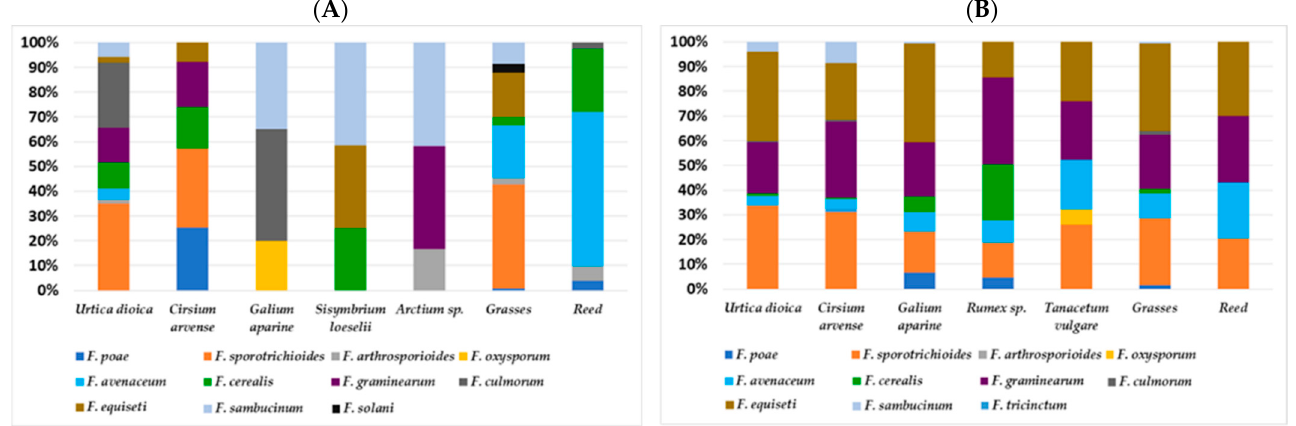
Figure 6. Quantitative community composition of Fusarium (F.) species (in %) based on the Fusarium abundances (FUS_cfu/gFM) of all different arable weeds analyzed in 2018 ( A ) and 2019/2020 ( B ) summarized over all sampling dates in autumn/winter and all edges of kettle holes ( n = 9/year) investigated in each season.